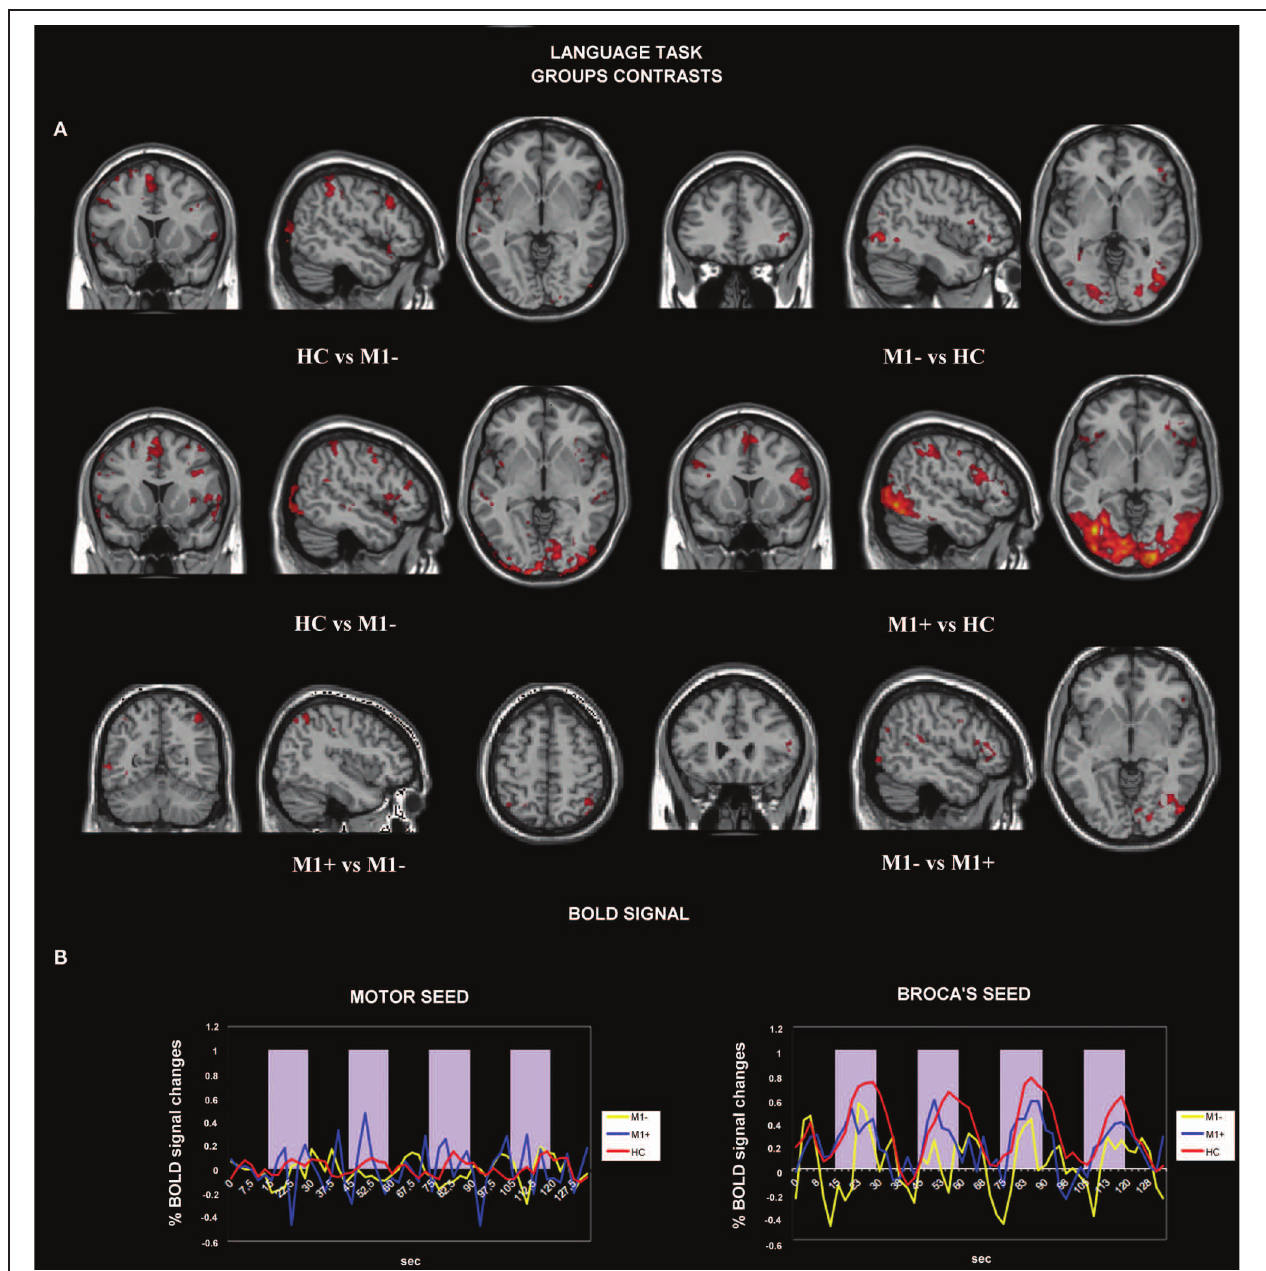
FIGURE 3 | (A) Activation maps for whole-brain GLM analysis related to verb generation task vs. rest. The contrast data between groups are presented at a threshold of p < 0 . 05, cluster corrected for Z > 2 . 3. (B) Average BOLD signal time-course extracted from the motor seed ROI